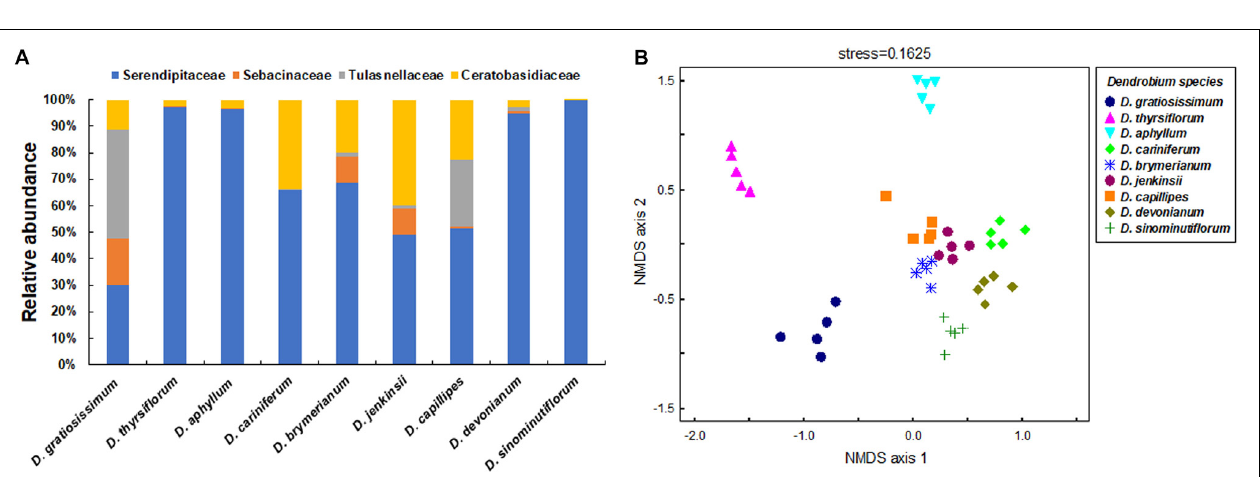
FIGURE 2 | Differences in mycorrhizal fungal community composition between the nine co-occurring Dendrobium species in the traditional tea garden. (A) Relative abundance of mycorrhizal fungal families associating with the nine Dendrobium species. (B) Non-metric multidimensional scaling (NMDS) plot illustrating differences in mycorrhizal communities between the nine Dendrobium species. Each data point represents an individual